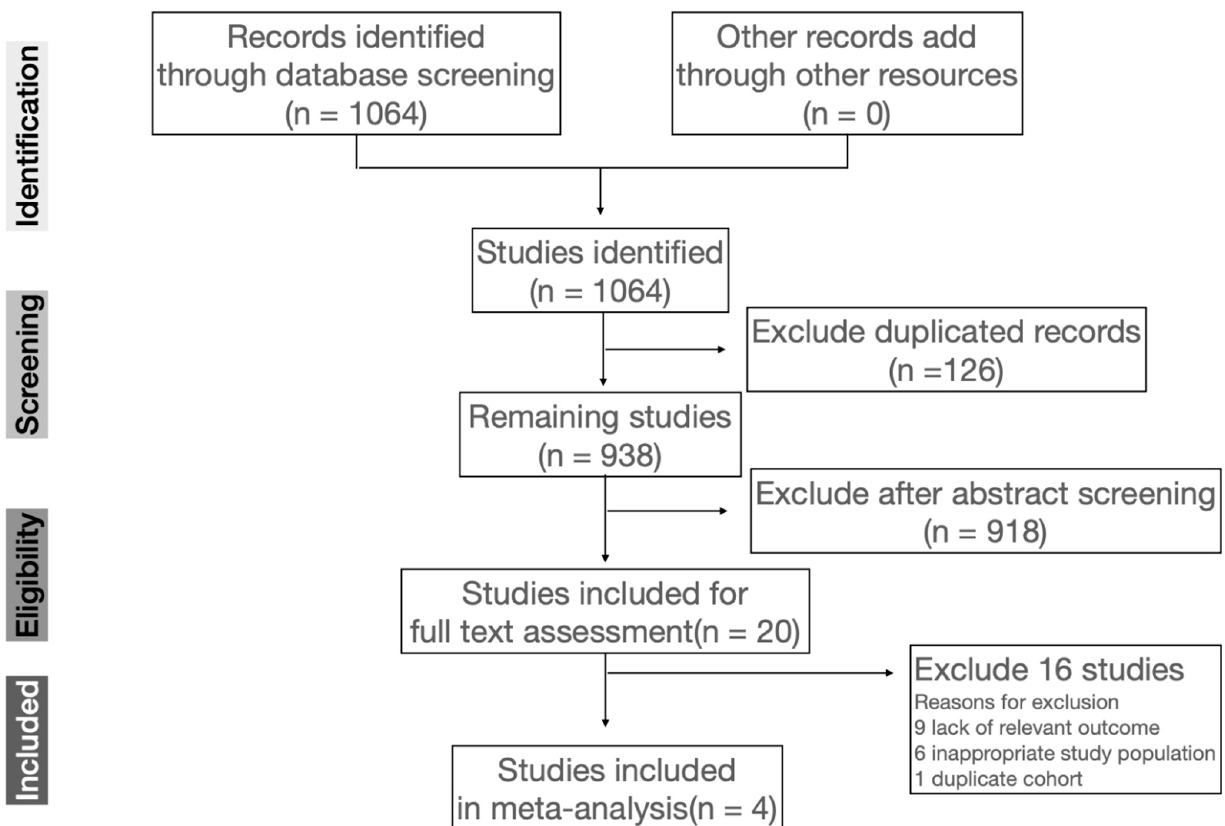
Figure 1. The protocol of this systematic review.